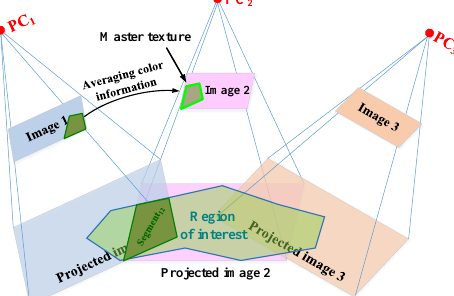
Figure 11. Rendering a segment which is visible in two images